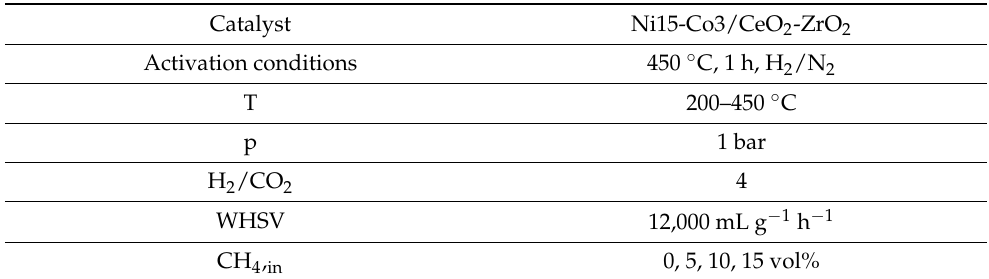
Table 9. Catalyst and reaction conditions for experiments on CH 4 influence on methanation with Co-promoted Ni/CeO 2 -ZrO 2 [1].